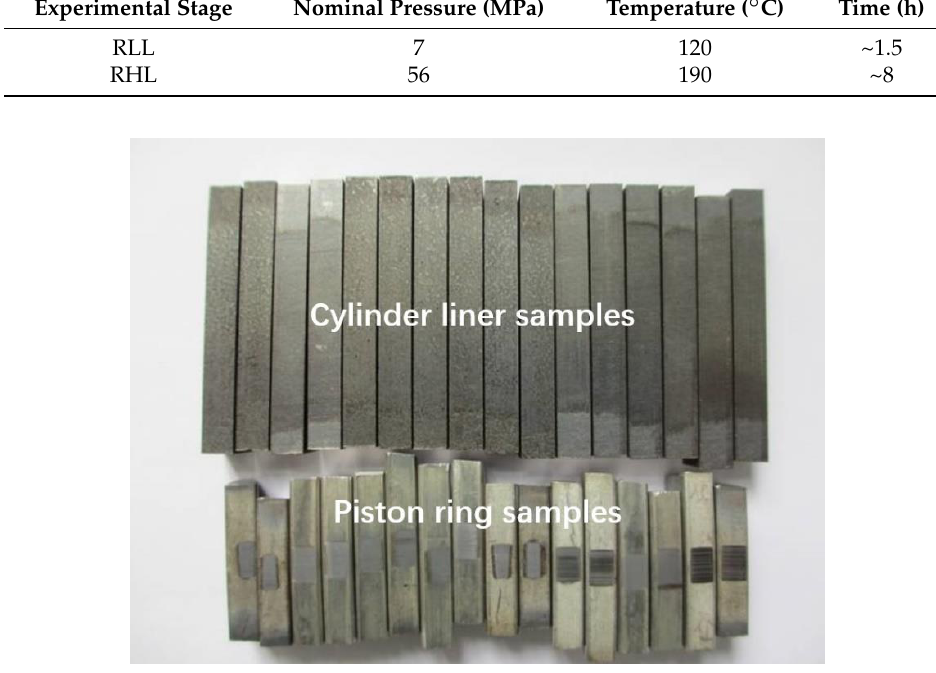
Figure 5. The typical tested piston ring and cylinder liner (PRCL) samples.